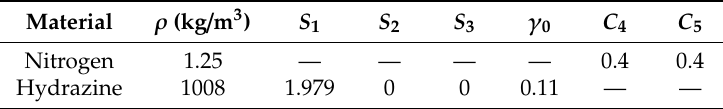
Table 4. Material parameters of nitrogen and liquid hydrazine.